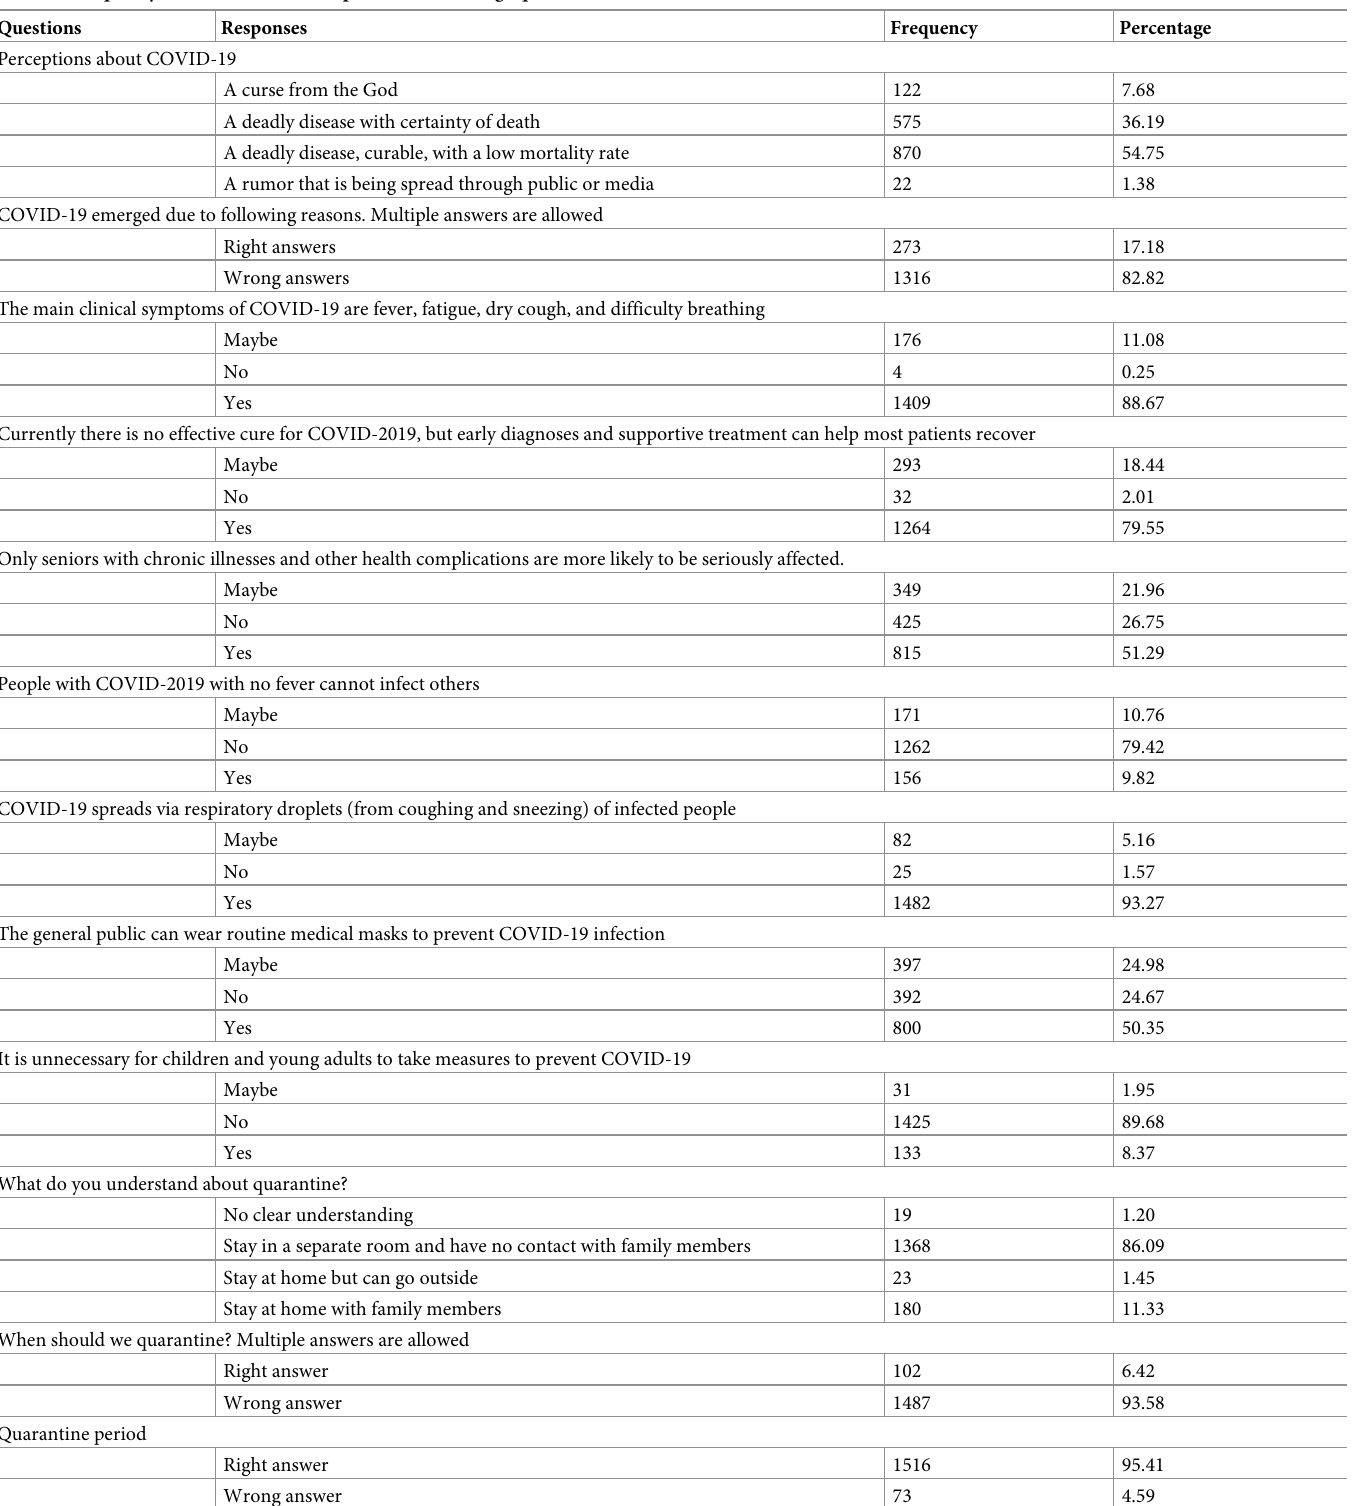
Table 3. Frequency distribution of the responses to knowledge